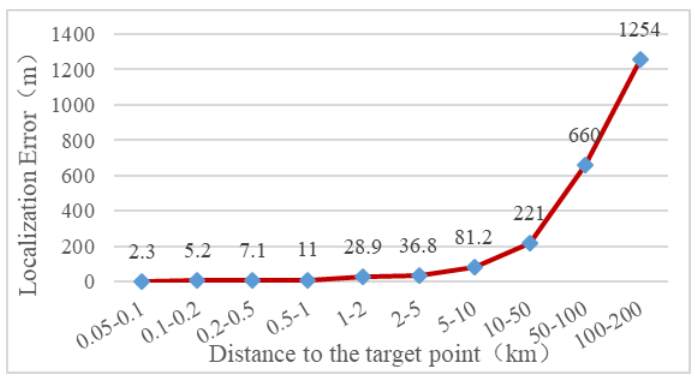
Figure 17. The relationship between distance and localization error.